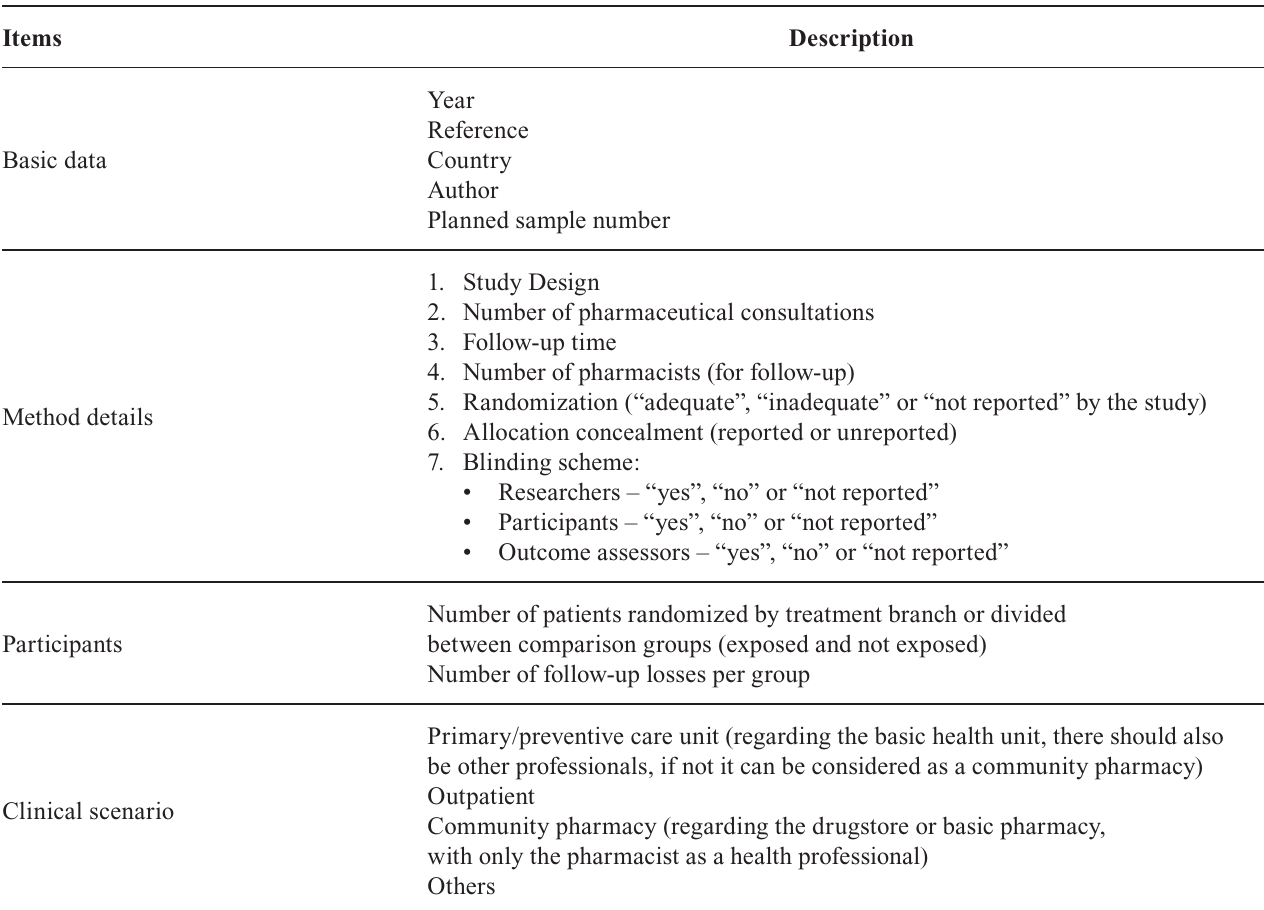
TABLE V - Checklist for Data extraction in this protocol and building the worksheet for databank